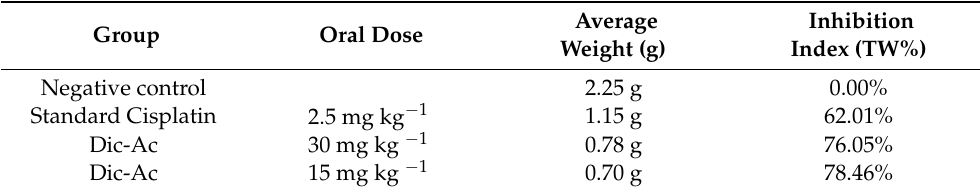
Figure 3. The effect of Dic-Ac phase in the unit weight of the tumors. Mice were treated with Dic- Ac (15 and 30 mg kg − 1 ), vehicle (0.9% saline) and standard (cisplatin 2 mg kg − 1 ) orally. Data are expressed as means ± SEM; n = 5 mice per group. * p < 0.05; ** p < 0.01. Significant after two- way analysis of variance (ANOVA), followed by the Tukey’s multiple comparison test with 95% confidence interval. Table 6. Inhibition of tumor growth in mice from control groups and treated with Dic-Ac 30 mg kg − 1 and 15 mg kg − 1